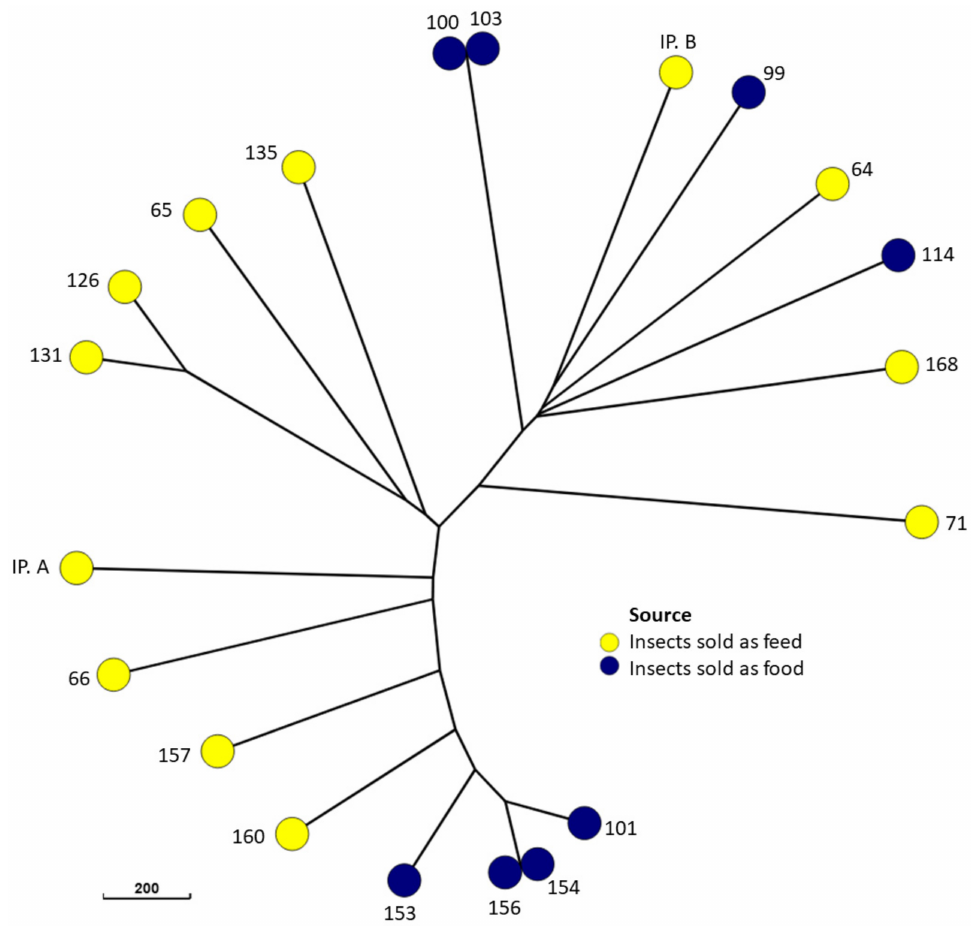
Figure 2. Minimum spanning tree of the 21 E. coli isolates based on core genome